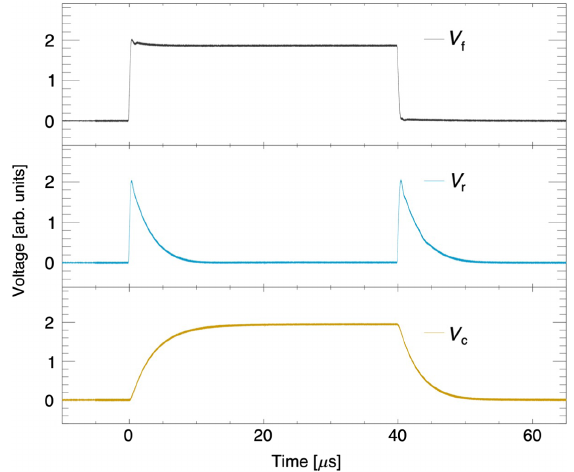
simulation.FIG. 13. rf waveforms of forward (top), reflected (middle), and cavity pickup voltages (bottom) at the nominal peak power of 75